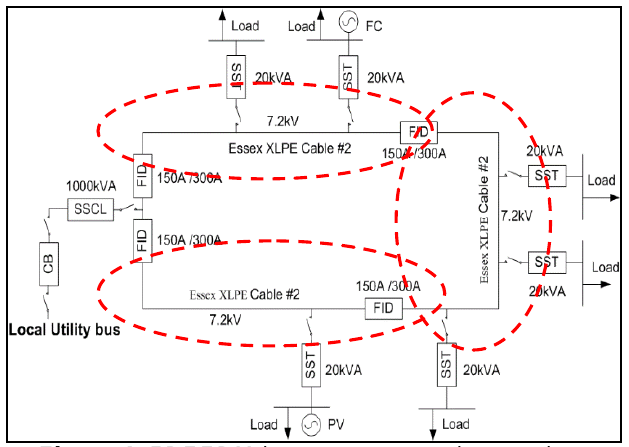
Figure 1. FREEDM loop structure and protection method